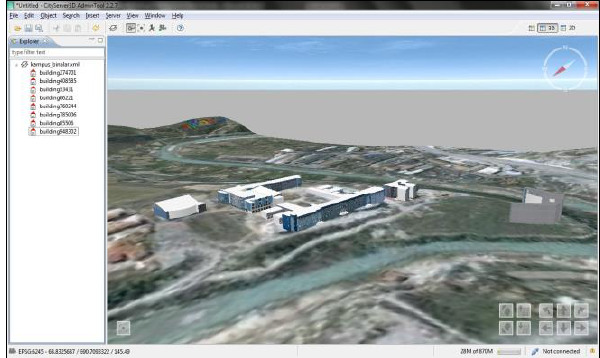
Figure 14. Visualization of the study